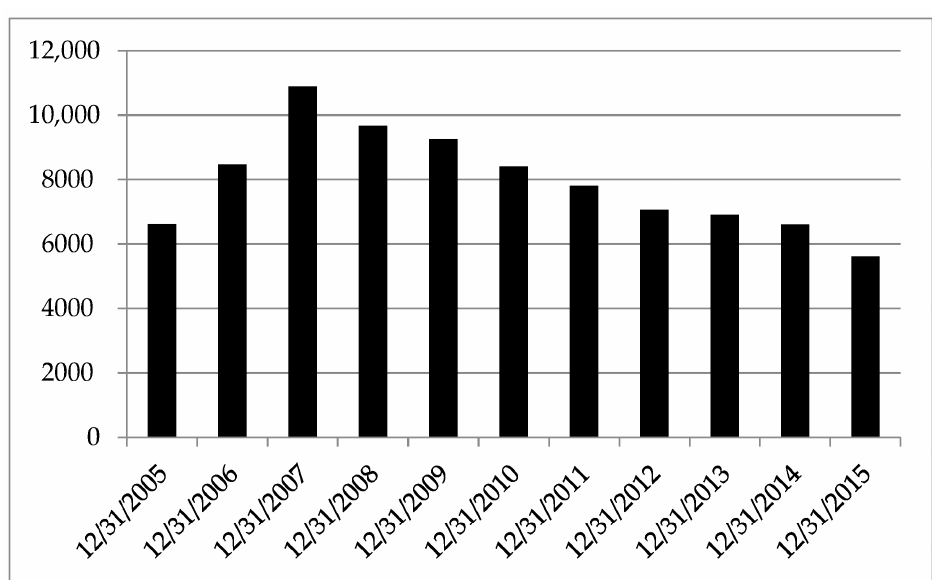
Figure 1. Foreign claims of reporting Euro area banks during the 2005–15 period (outstanding amounts at end-period, in billions of U.S. dollars). Source: Locational banking statistics (LBS_D_PUB), Bank for International Settlements, January